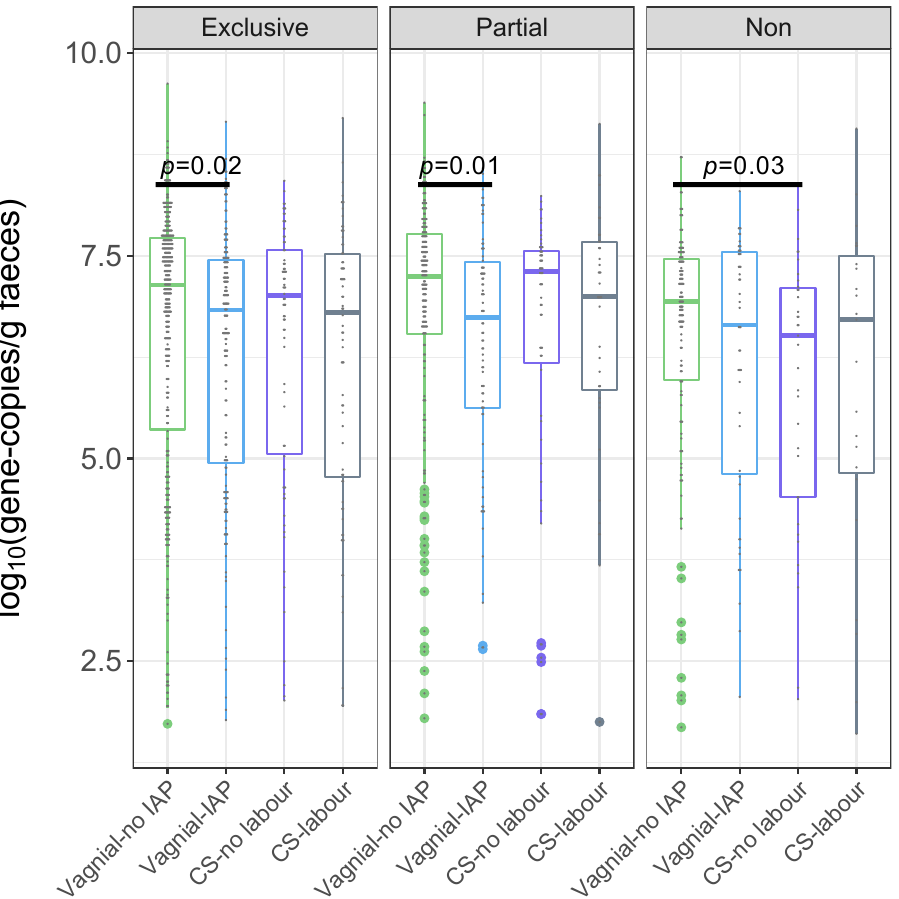
Figure 2. Birth mode comparisons of the absolute quantity of genus Bifidobacterium by qPCR within exclusively breastfed, partially breastfed and non-breastfed infants at 3 months of age. p values are from crude linear regression models of the Box–Cox transformed absolute quantity of genus Bifidobacterium . Vaginal-no IAP is the reference